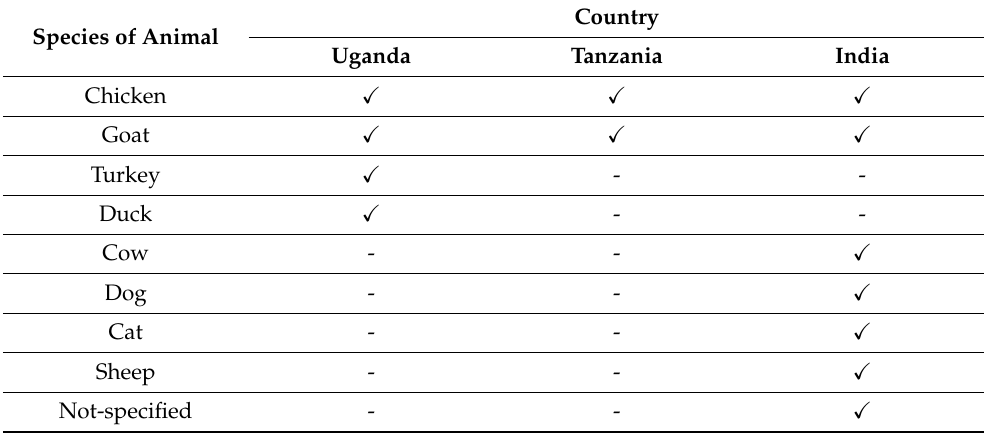
Table 1. Animal species treated with human antibiotics in each country. Species of